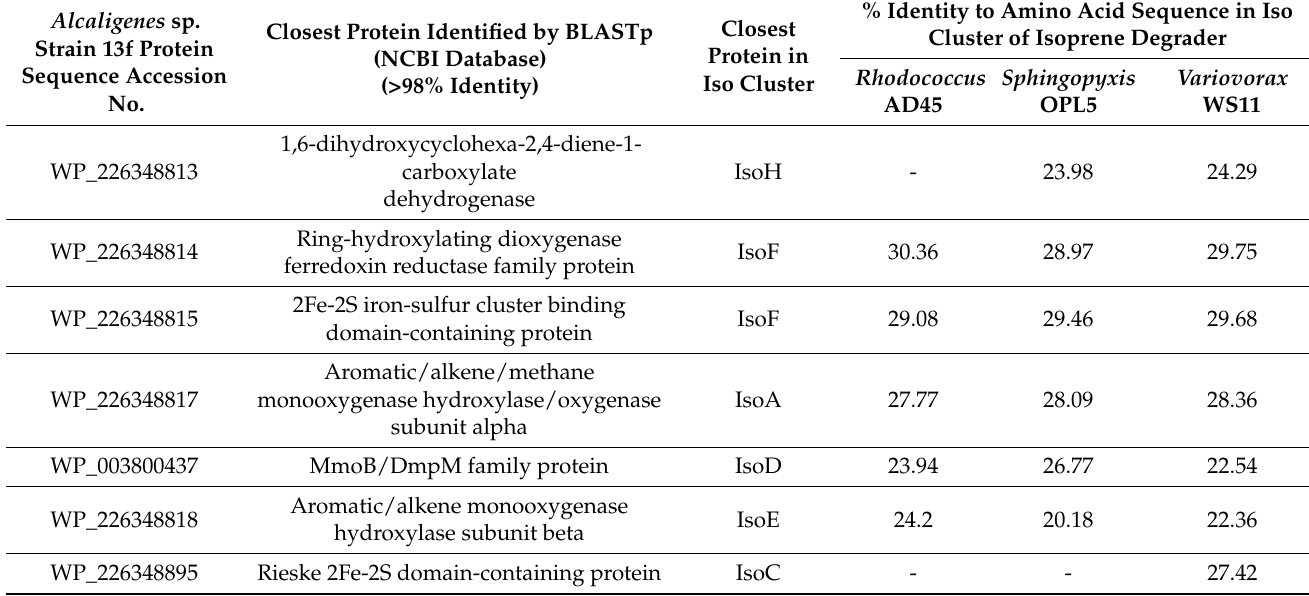
Table 2. Percentages of protein sequence identity derived from Alcaligenes sp. strain 13f compared with proteins in the Iso metabolic cluster of isoprene-degrading